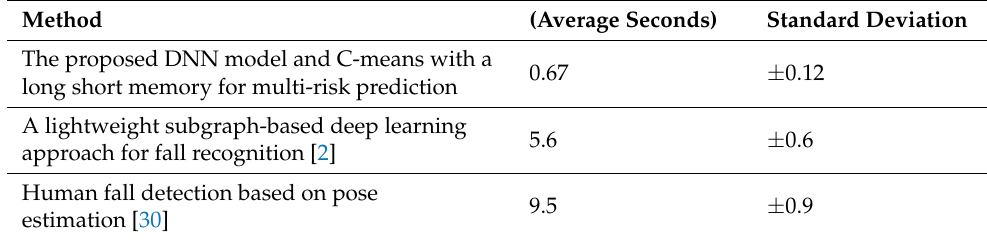
Table 13. Classification CPU time of training of all